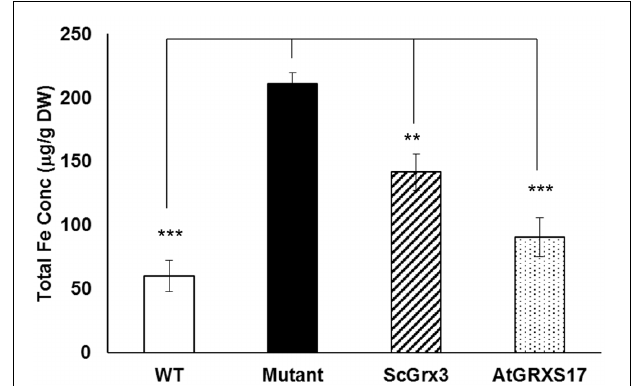
FIGURE 1 | AtGRXS17 suppresses yeast grx3grx4 iron accumulation phenotypes. Yeast wild type and grx3grx4 cells expressing empty vector and plasmid DNA as indicated were grown in YPD medium overnight and whole cell iron concentrations were measured by inductively coupled plasma optical emission spectrometry. Results represent the mean value of three independent replications. Student’s t -test, ∗∗ p < 0.01, ∗∗∗ p < 0.001.